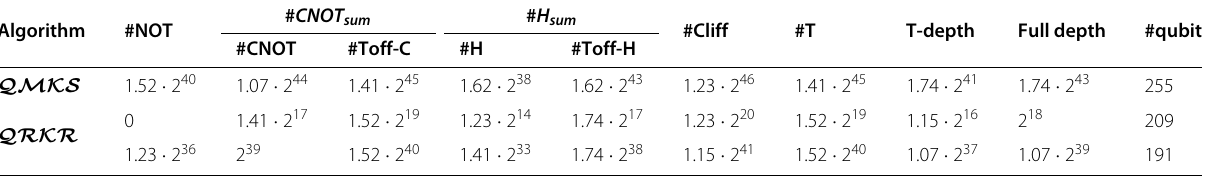
Table 9 The cost comparison between QMKS and